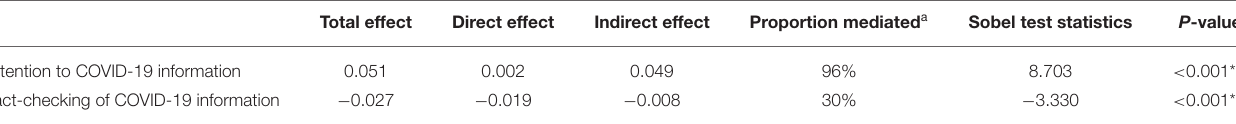
TABLE 4 | The mediating effect of fear for the associations of attention and fact-checking with delay in